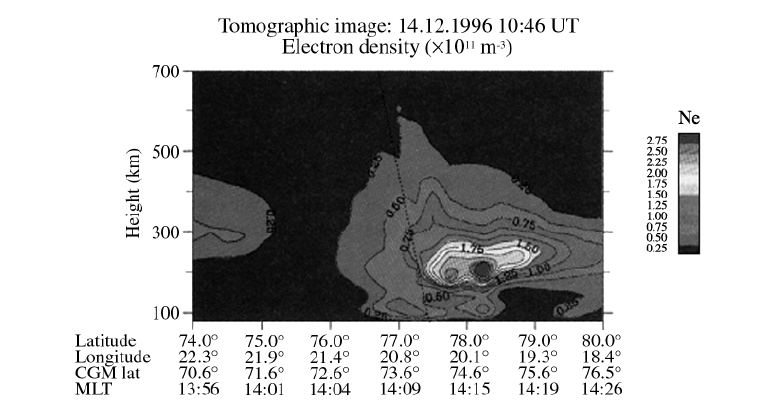
Fig. 14. Tomographic image showing signatures in the high-latitude ionosphere of reconnection at the equato- rial magnetopause. From Walker et al. (1998), reproduced in modified form by permission of the American Geo- physical Union.